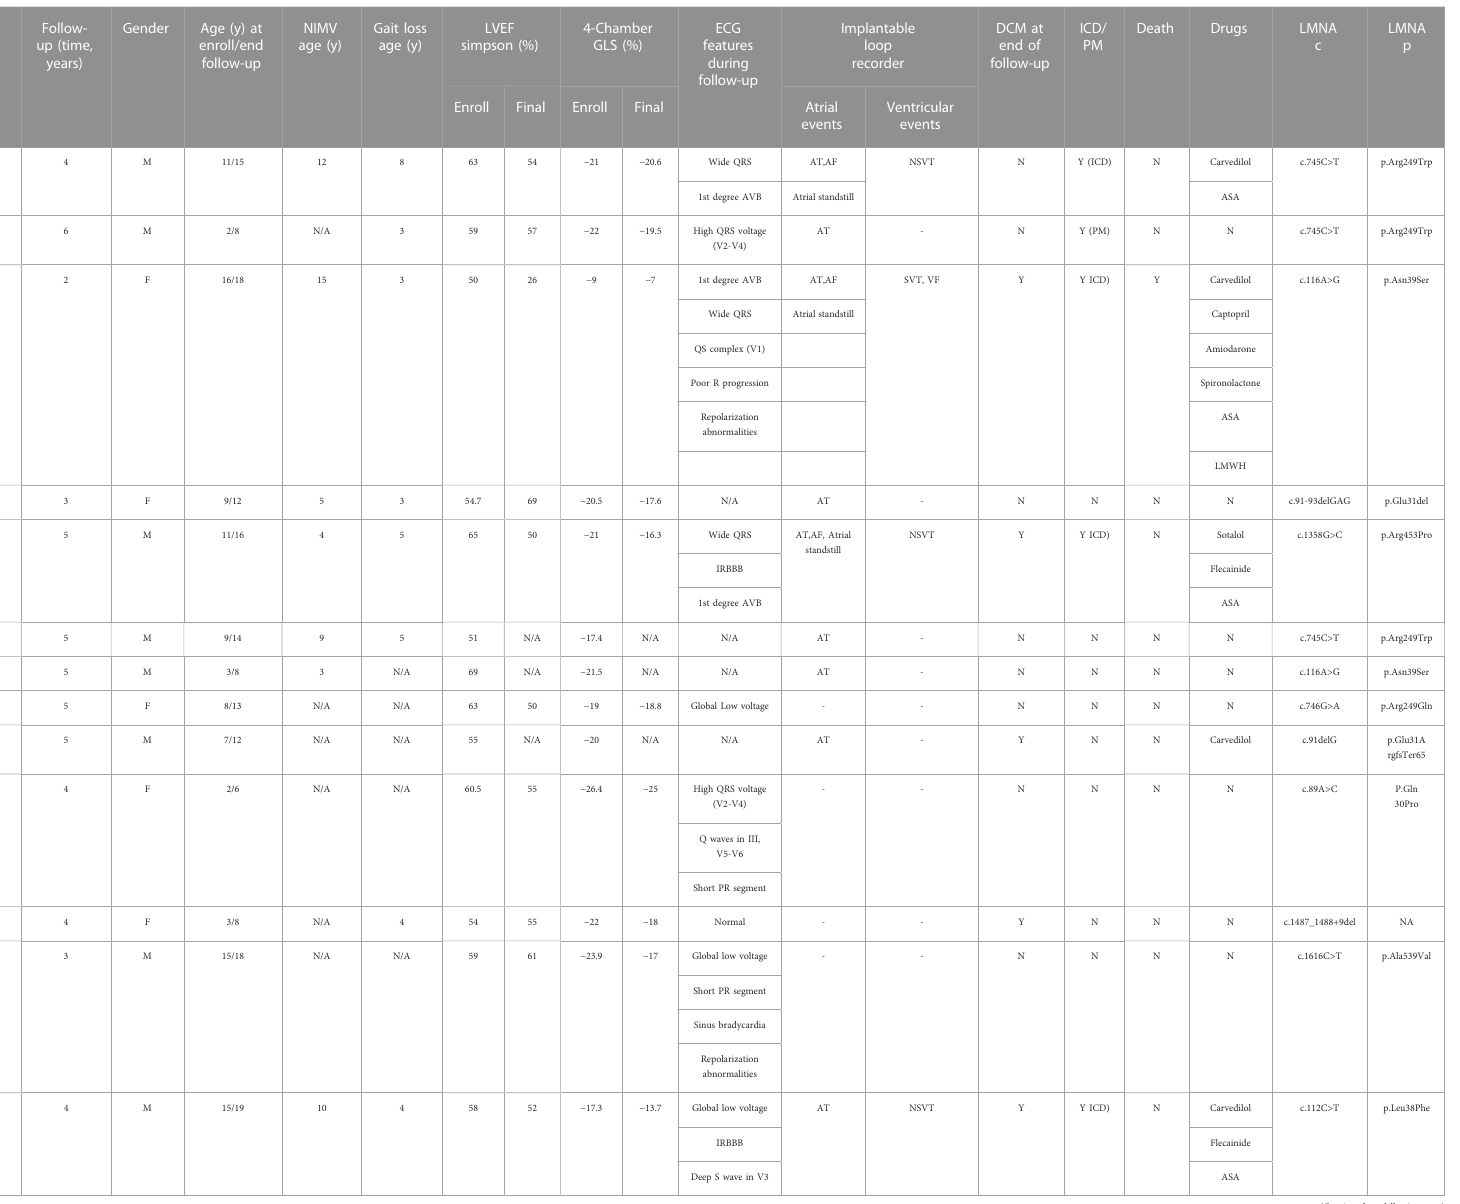
TABLE 2 Demographic data and overall